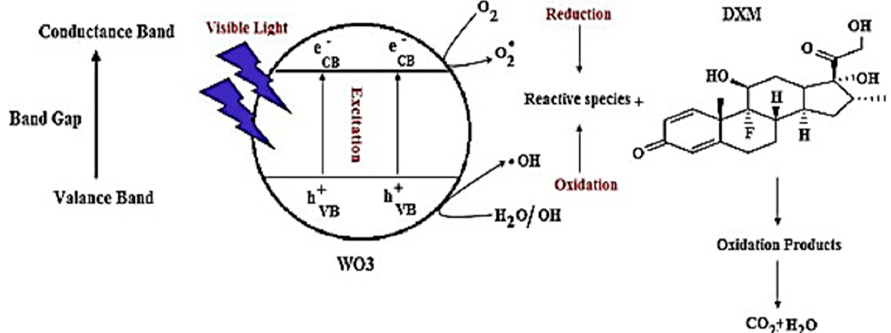
Figure 6. Photocatalytic-based degradation mechanism of DXM in the presence of WO 3 nanoparticles. Reprinted/adapted with permission from Ref. [119]. Copyright 2019 Elsevier.